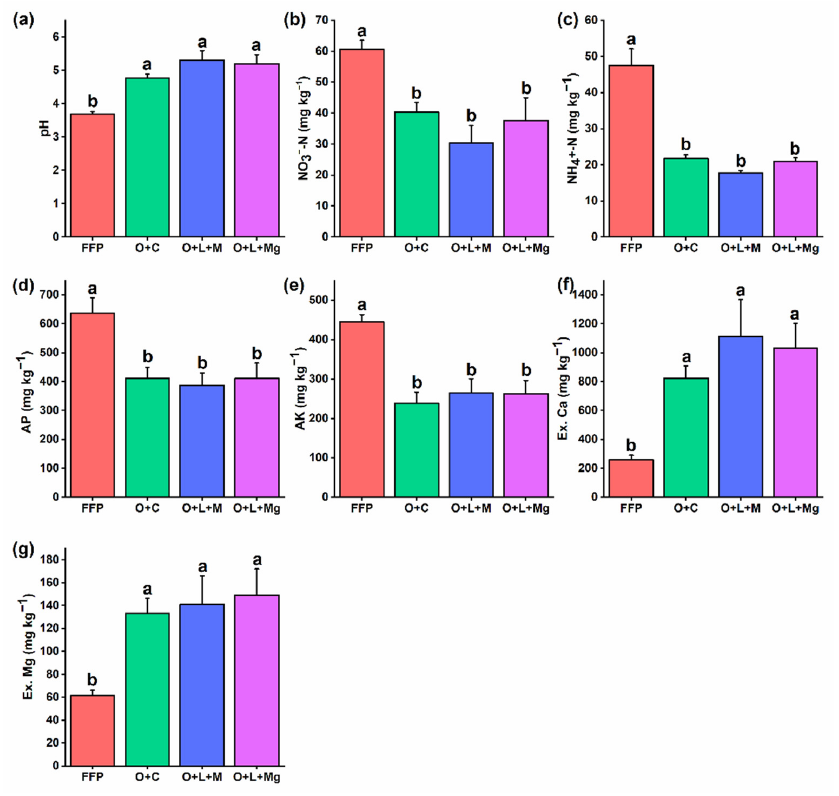
Figure 1. Effect of different management practices on soil properties. The effect of different nutrient management practices was compared with farmer fertilizer practice in terms of soil physicochemical properties: ( a ) soil pH; ( b ) NO 3 − -N; ( c ) NH 4+ -N; ( d ) available phosphorous; ( e ) available potassium; ( f ) exchangeable calcium; ( g ) exchangeable magnesium. The different lowercase letters indicate significant differences ( p < 0.05) among different treatments.